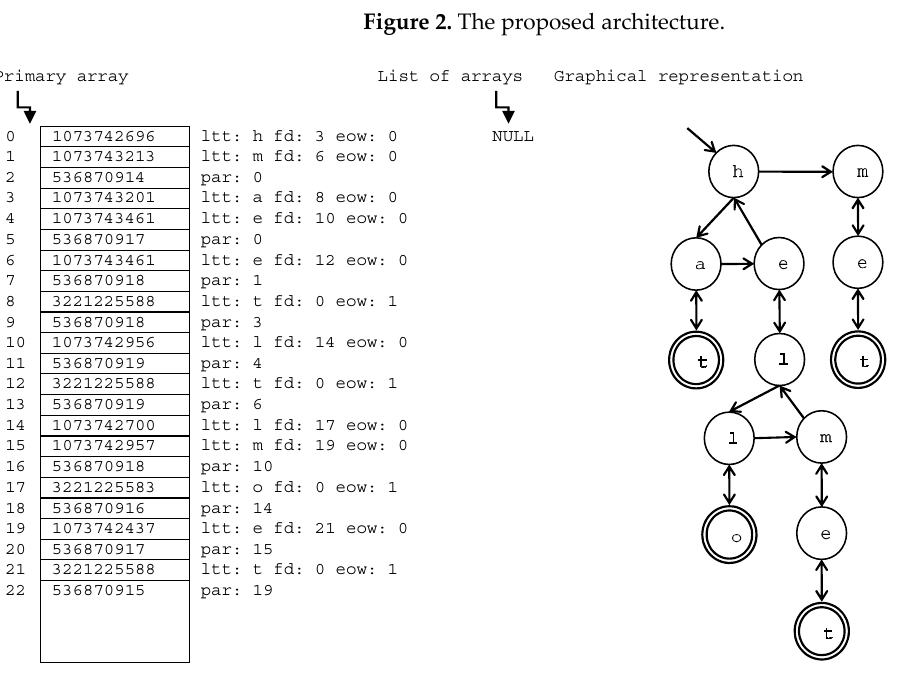
Figure 3. Trie with terms and identifiers: hat (8), hello (17), helmet (21) and met (12). (ltt: letter;